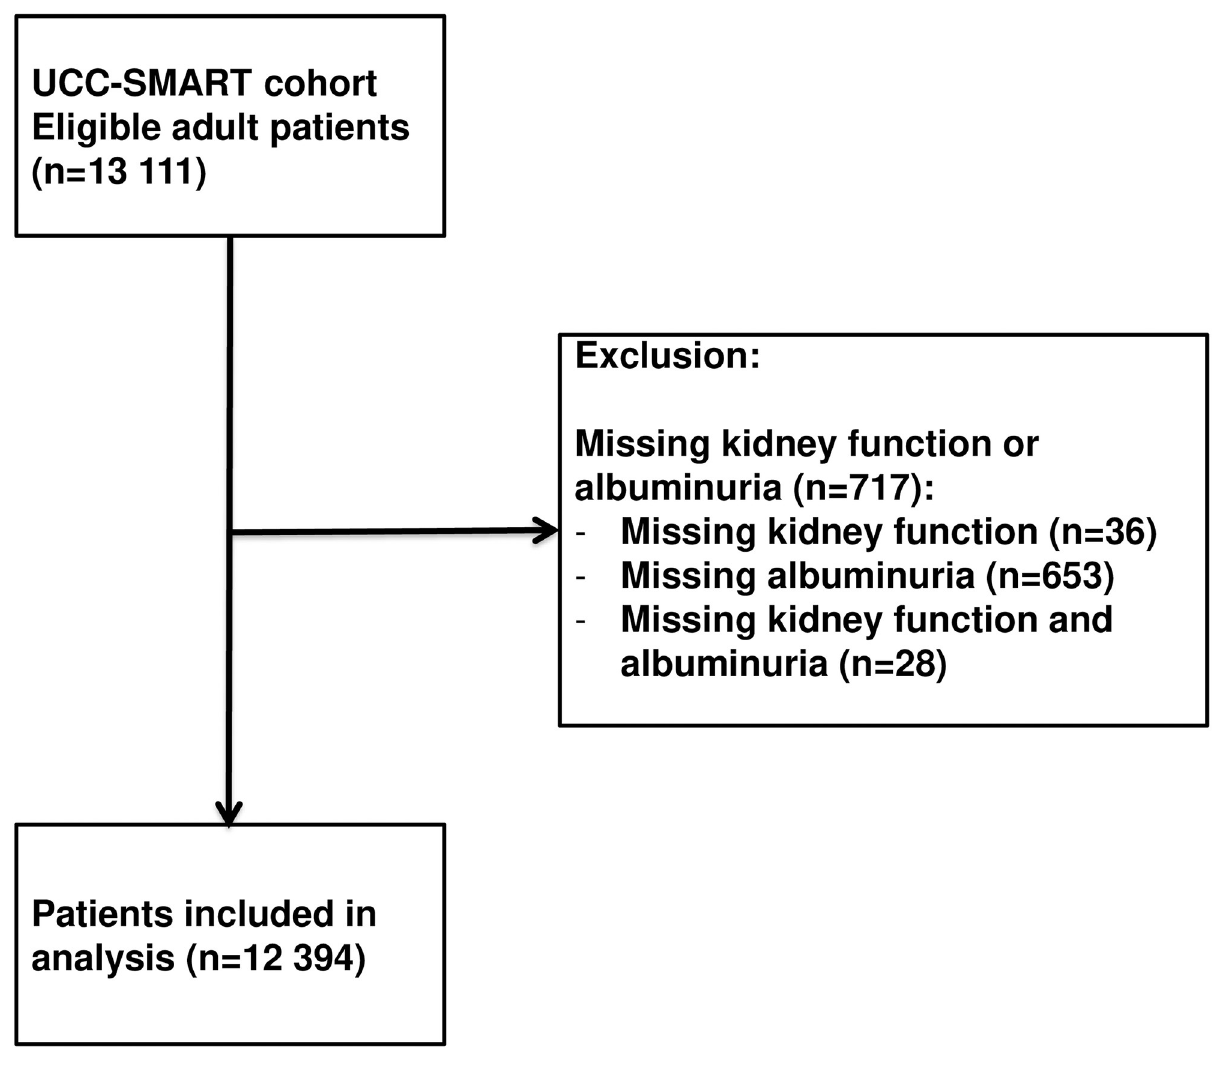
fibrillation and chronic kidney disease. Overall, 382 subjects developed a first bleeding event in the total cohort. Furthermore, 421 patients had a first ischemic stroke during the follow-up period. Combination of chronic kidney disease and atrial fibrillation on bleeding risk Subjects without atrial fibrillation and chronic kidney disease had the lowest bleeding risk (incidence rate of 2.6 per 1,000 person-years) and patients with atrial fibrillation and chronic kidney disease had the highest bleeding risk (incidence rate of 17.2 per 1,000 person-years). The combination of atrial fibrillation and chronic kidney disease was associated with a 3.0-fold (95% CI 2.0–4.4) increased bleeding risk as compared with subjects without atrial fibrillation and chronic kidney disease (Table 2). There was no interaction between atrial fibrillation